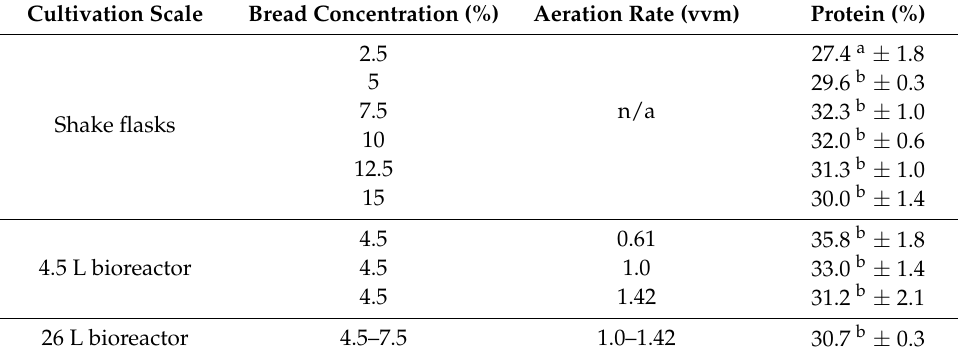
Table 5. Protein content of the harvested biomass.